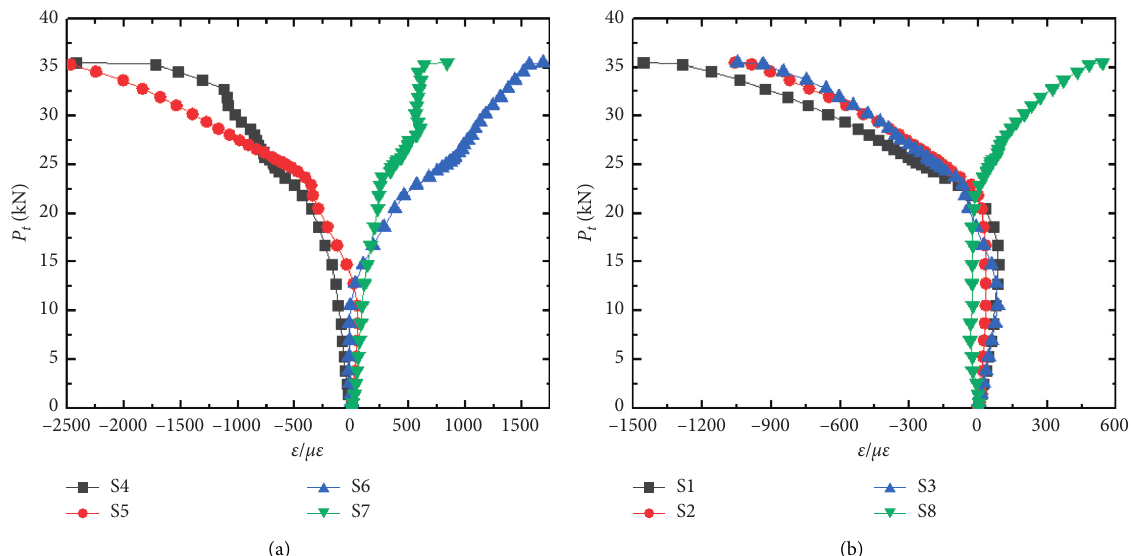
Figure 14: Load and strain curves for specimen C9008-03-CH71. (a) Midheight. (b) About 50mm higher than midheight.